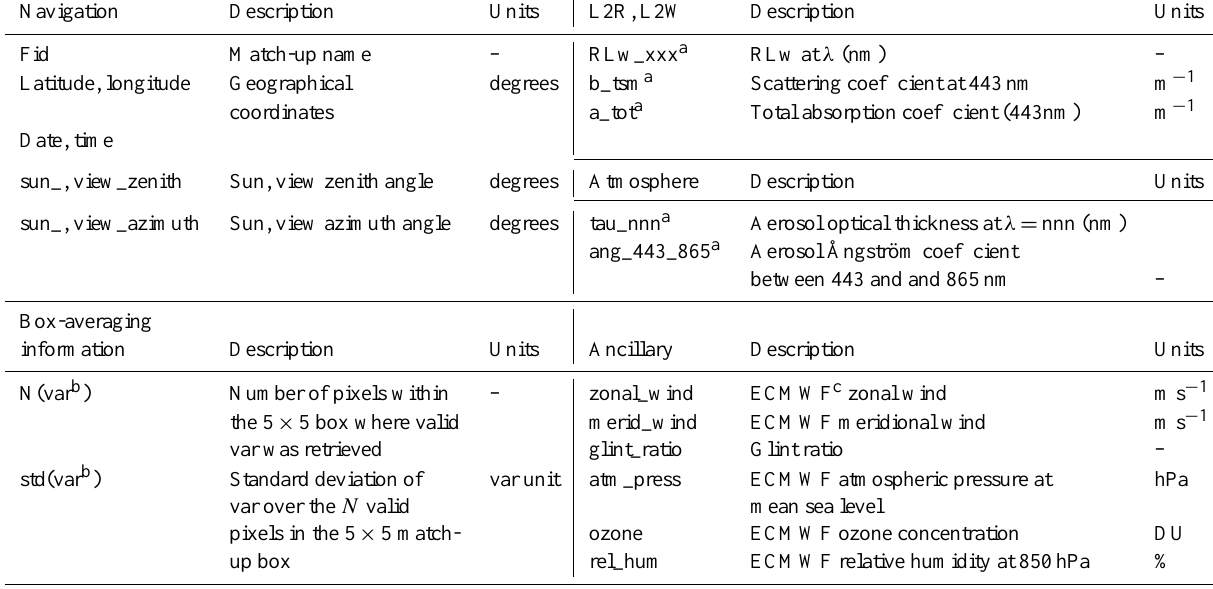
Table 8. The 5 × 5 box averaged L2R, L2W, and atmospheric parameters derived from the MERIS match-up data set.